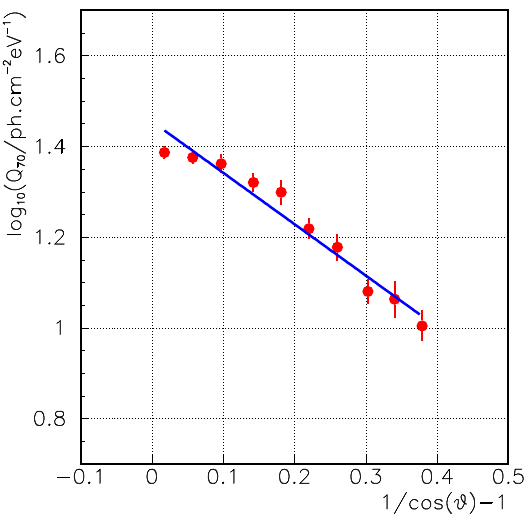
2 Figure 6. Experimental zenith angular dependence of Q 70